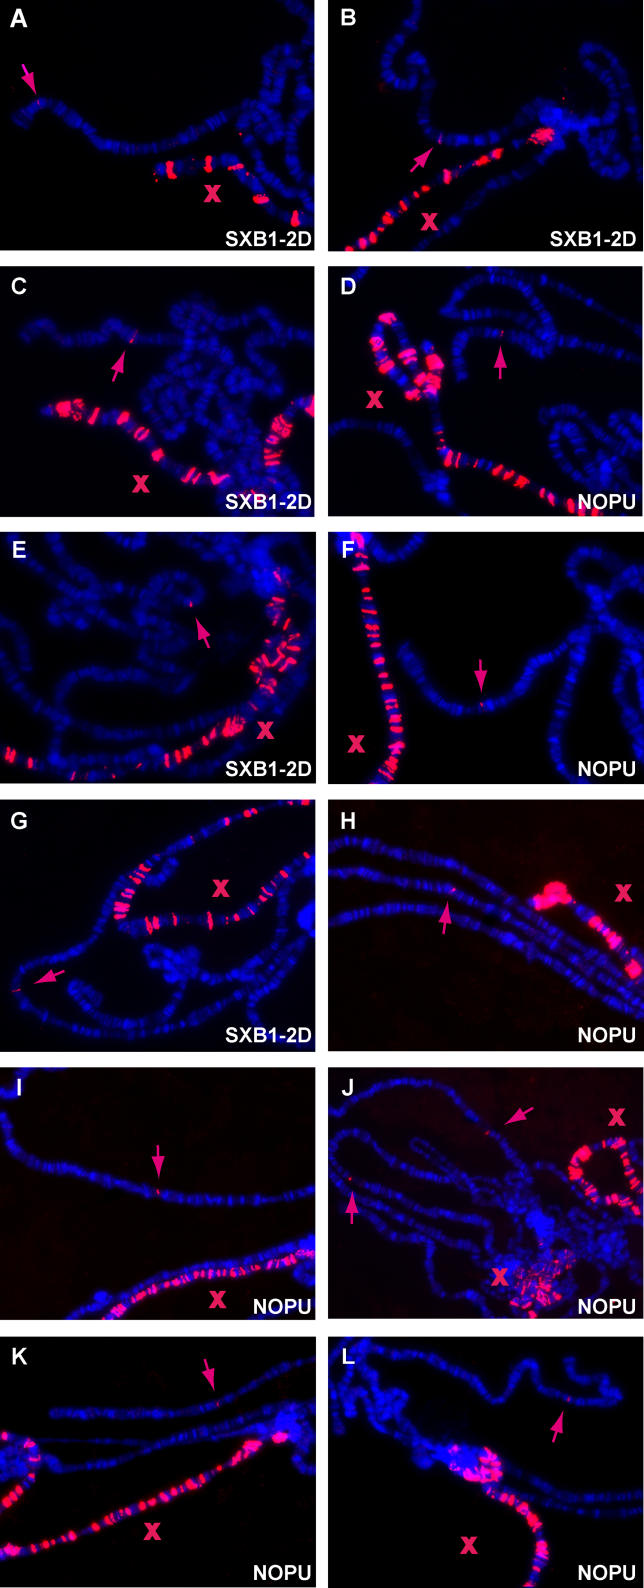
Several DCC Binding Fragments Can Recruit the Complex When MSL2 Levels Are LimitingExamples of DCC recruitment to DBF inserts in females carrying one copy of the SXB1–2 or NOPU MSL2 expression constructs (see Figure 1). Anti-MSL1 staining is shown in red and DNA staining in blue. Arrows indicate the position of the inserts and X indicates the X chromosome. Inserts DBF12-99EF (A), DBF12-85A (B), DBF9-96C (C), DBF6-100A (E), and DBF5-95C (G) recruit the DCC at lower levels of MSL2 in the SXB1–2 background, whereas inserts DBF9B-98F (D), DBF6-63C (F), DBF5-91F (H), DBF7-88E (I), DBF7-93B (J), DBF1-26A (K), and DBF9A-96D (L) recruit the complex in the NOPU background. For a summary of the complete results, see Table 2.